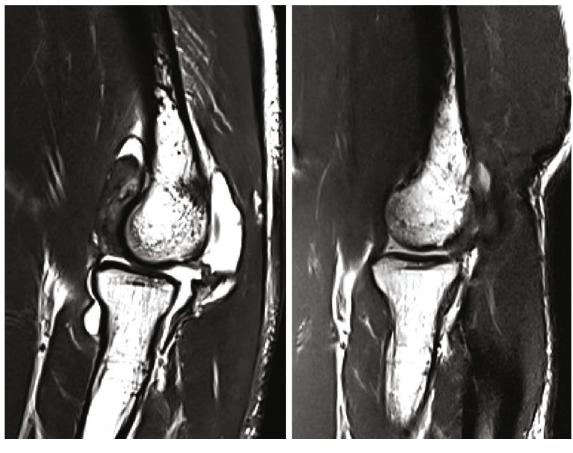
Figure 3: Preoperative and 6-month postoperative